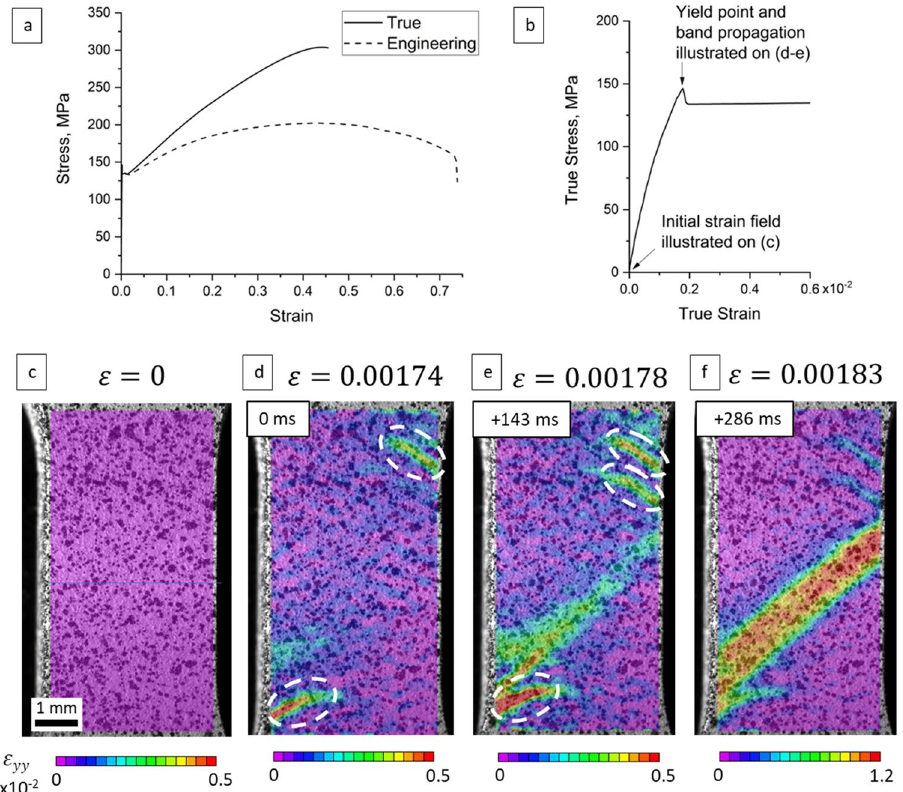
Figure 2. ( a ) Stress–strain curve of the Mg–1.5Nd alloy along with ( b ) a magnified portion governed by the yielding point phenomena. ( c – f ) DIC strain fields (ε yy ) over the entire gauge section of the specimen in which the dashed ovals highlight tongue-shaped elasto-plastic strain localizations prior to the formation of a dominant deformation